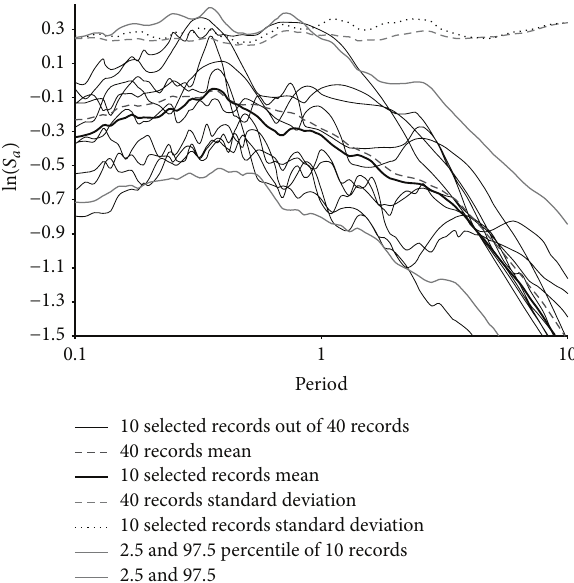
Figure 1: The logarithmic response spectrum of individual records and their logarithmic mean and